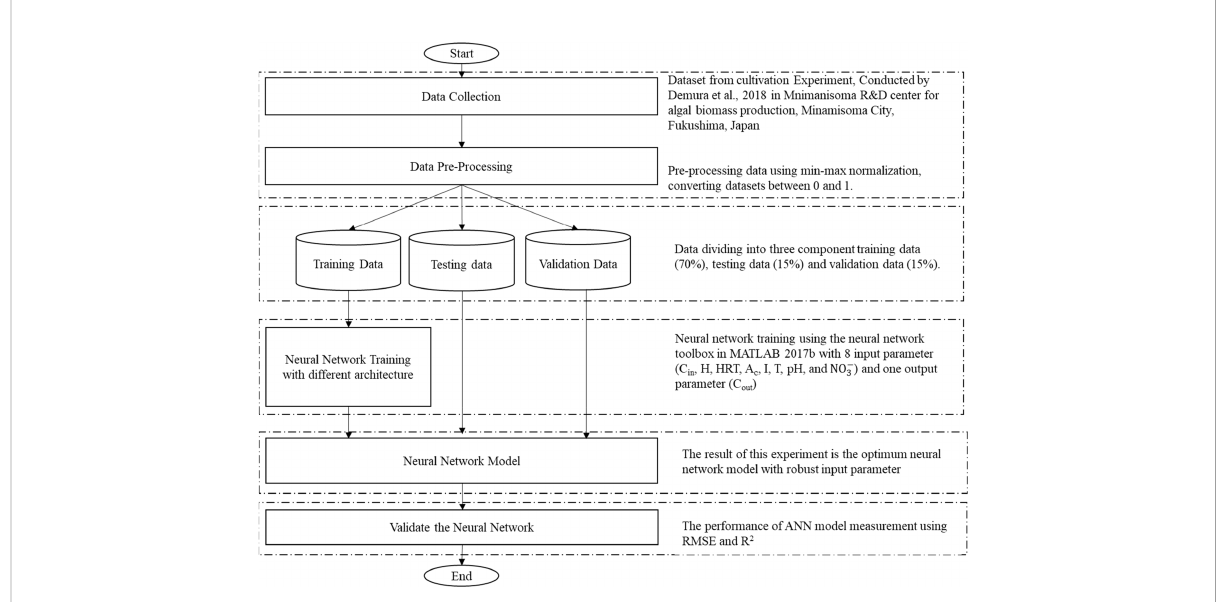
FIGURE 9 Schematic representation of a framework used to estimate microalgae growth with ANN. (reproduced with permission from Supriyanto et al.,